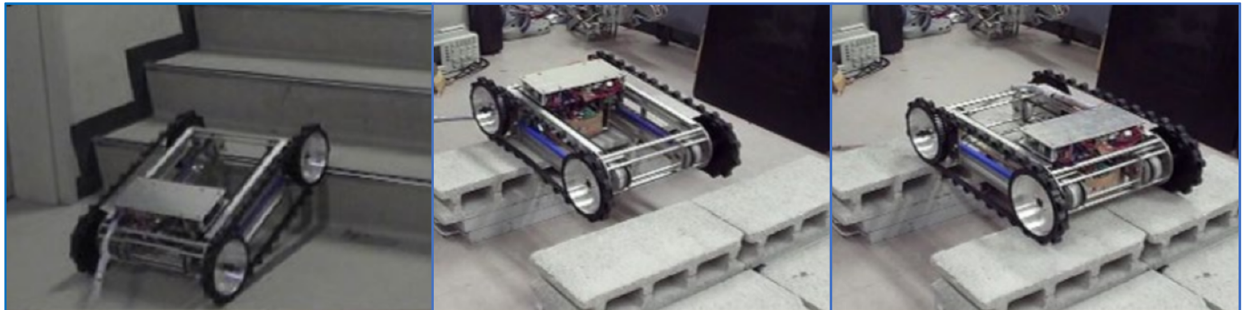
Figure 3. Dyjob robot, TGMR-NA with movable center of gravity: the center of gravity can be moved longitudinally to face the first step of a stair ( left ) or to maintain stability during gap traversing ( center and right ).